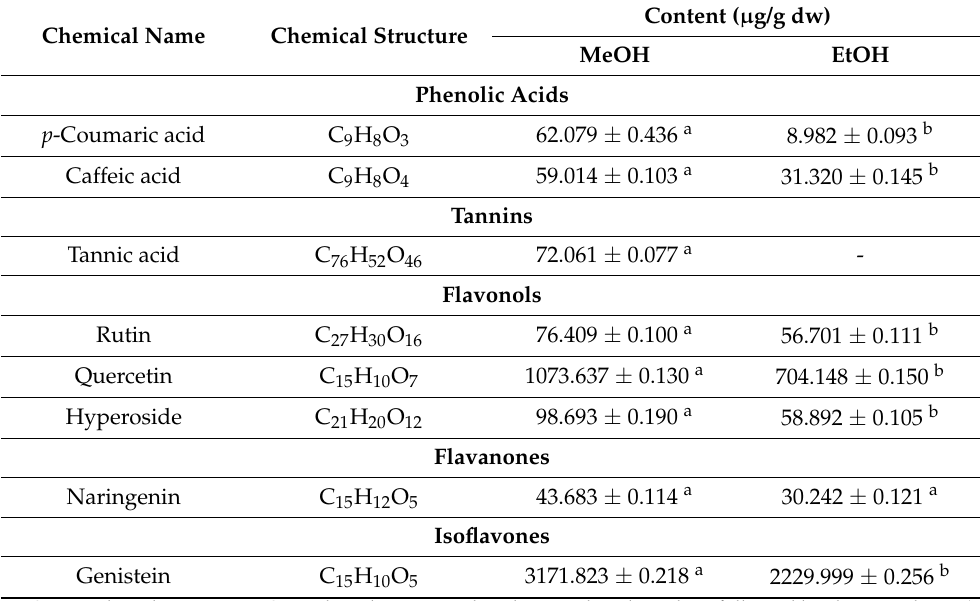
Table 3. Bioactive compounds contained in ethanolic (EtOH) and methanolic (MeOH) extracts of A. foeniculum